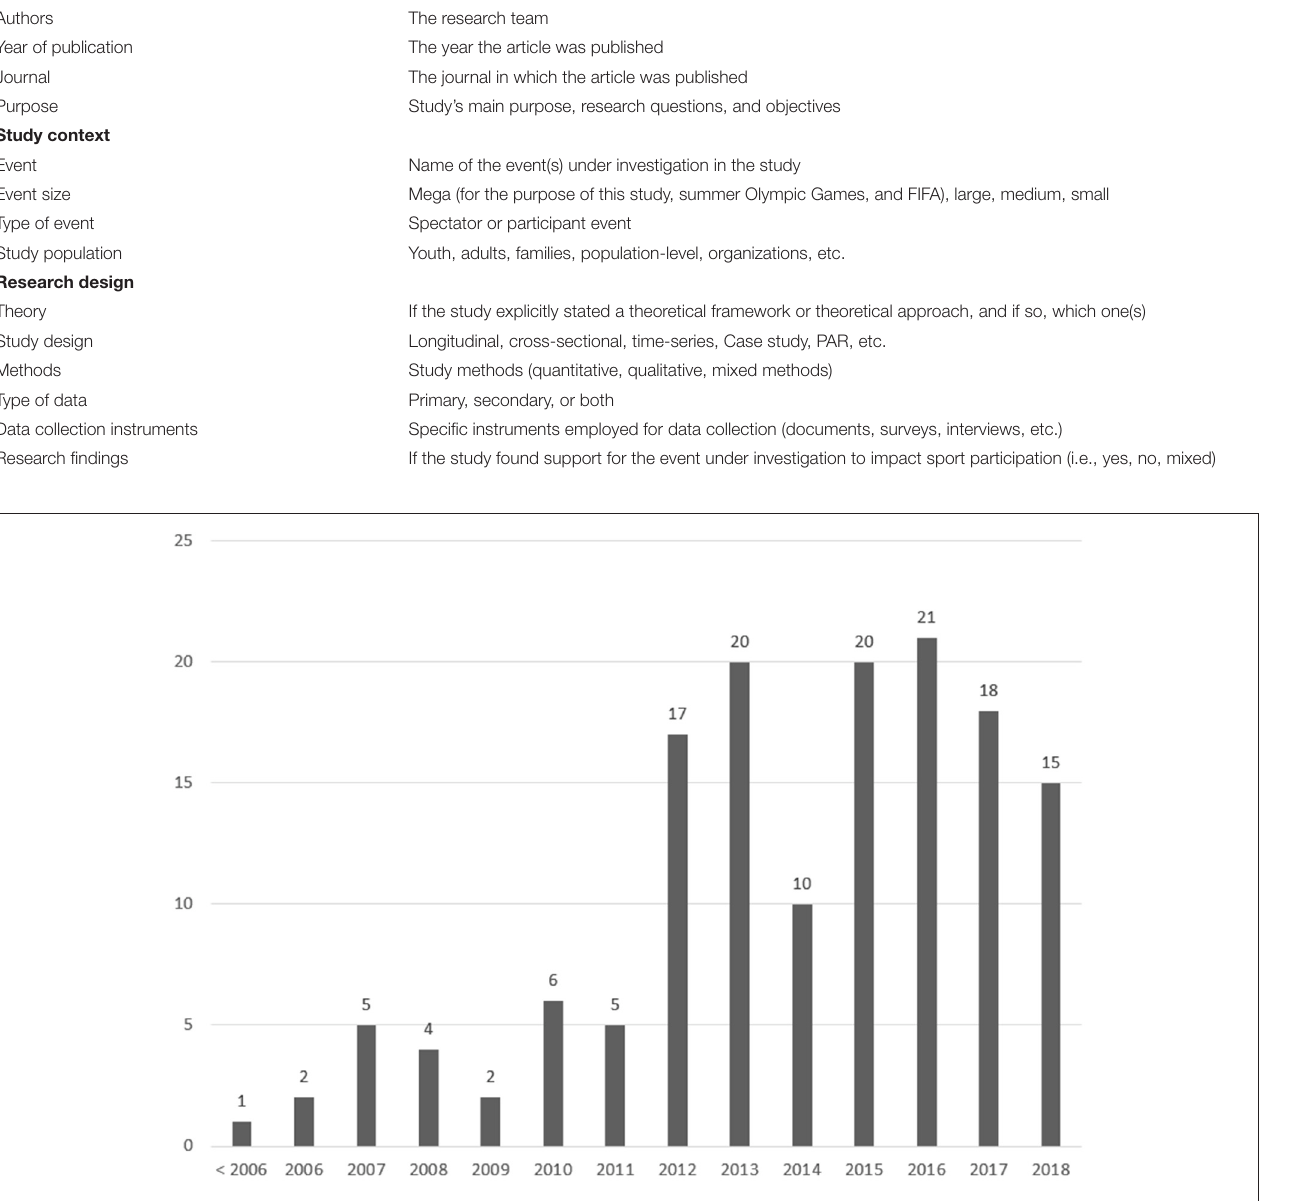
FIGURE 2 | Year of